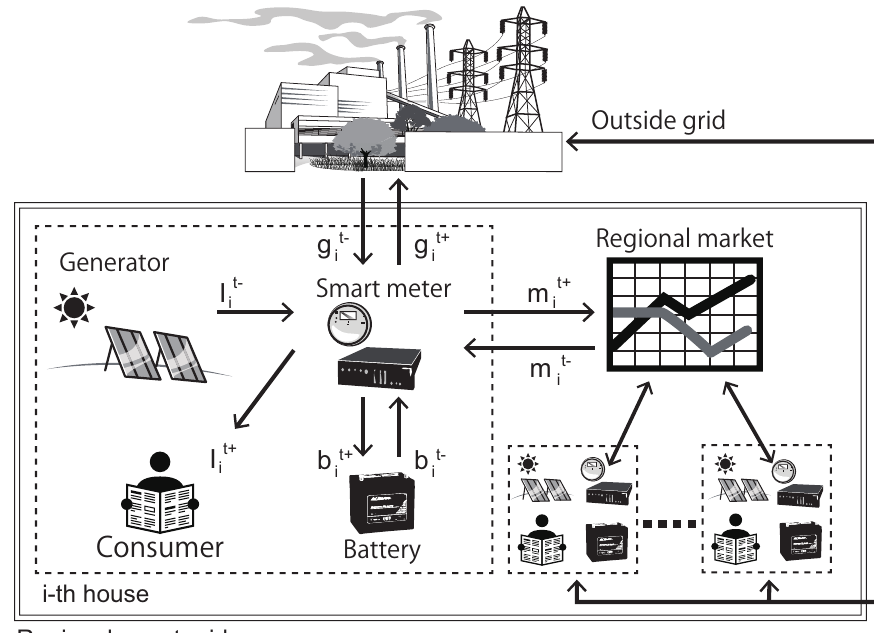
Figure 3. Power flow in the inter-intelligent renewable energy network